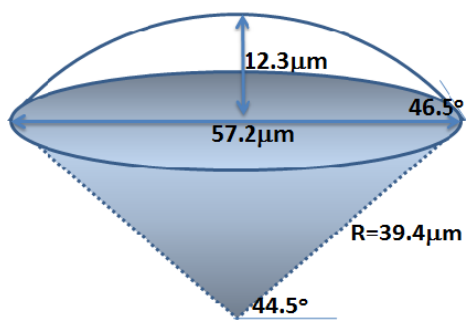
Figure 7. Parameter designation of the spherical crown microstructure.